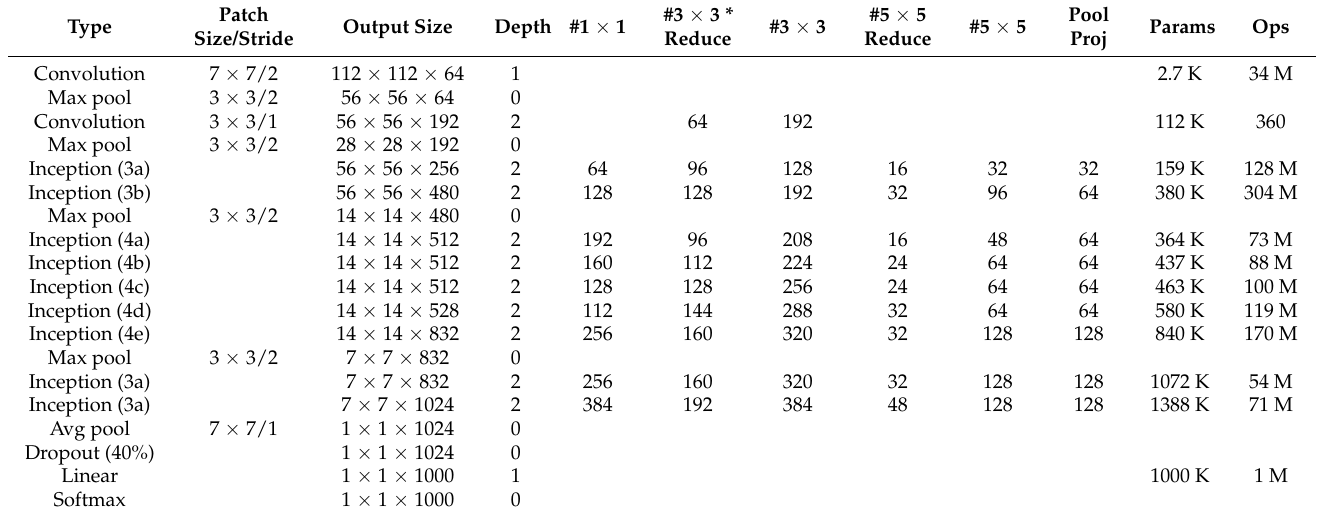
Table 2. The network architecture of GoogLeNet. Reprinted with permission from Ref. [47]. 2014, Szegedy, et